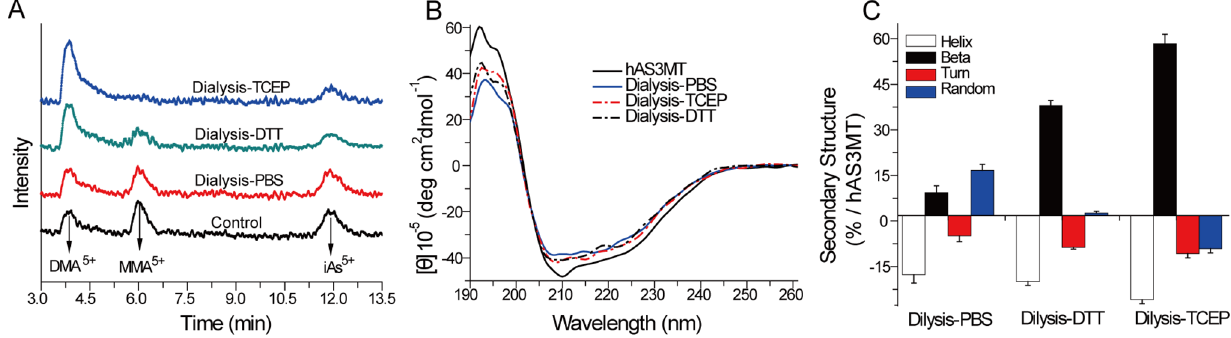
Figure 8. Recovery effects of TCEP and DTT on the enzymatic methylation of iAs 3 + . (A) HPLC-ICP-MS spectra of arsenic species on hAS3MT. Control: hAS3MT (2.0 m M) catalyzed the iAs 3 + methylation in the GSH reaction system for 60 min and dialysis against PBS. Dialysis-PBS, Dialysis-DTT (0.5 mM), and Dialysis-TCEP (0.7 mM): PBS, DTT, or TCEP separately incubated with the dialyzed hAS3MT in the presence of AdoMet (0.1 mM) at 37 u C for another 60 min. (B) CD spectra and (C) corresponding secondary structure of hAS3MT. Enzyme: hAS3MT (2.0 m M) in PBS. Error bars represent S.D. from the mean of three independent experiments. doi:10.1371/journal.pone.0110924.g008 PLOS ONE |